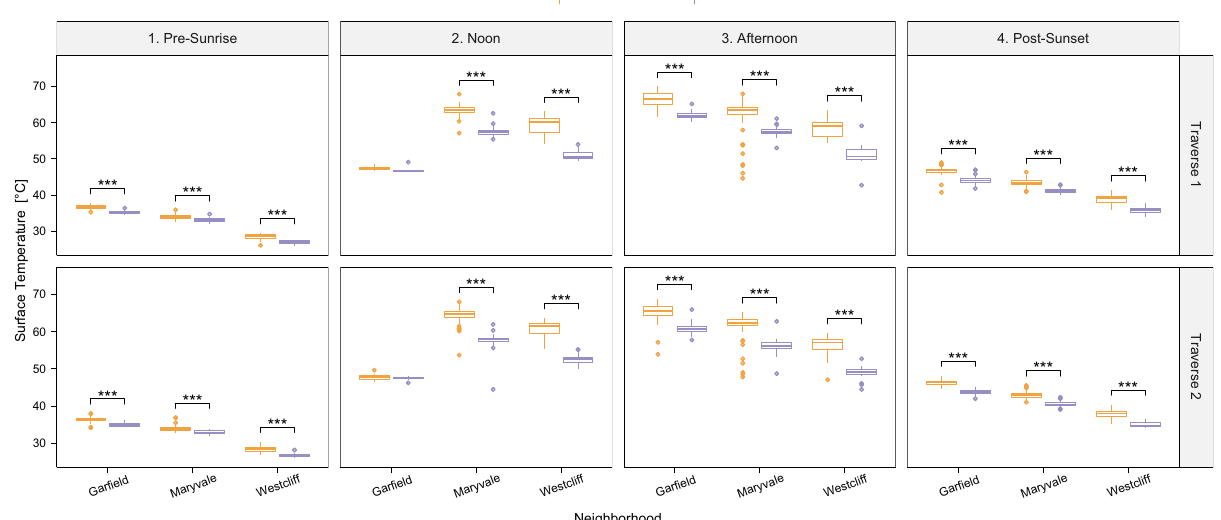
Fig.3|Overviewofsurfacetemperaturemeasurementsforallareasandtimes. Car transect-derived surface temperature panel for all neighborhoods, transects, and traverses in box-whisker plots. Center line=median; box limits=upper and lower quartiles; whiskers=1.5x interquartile range; points=outliers. Asphalt con- crete, AC (orange), and re fl ective pavement, RP (purple), surface temperature